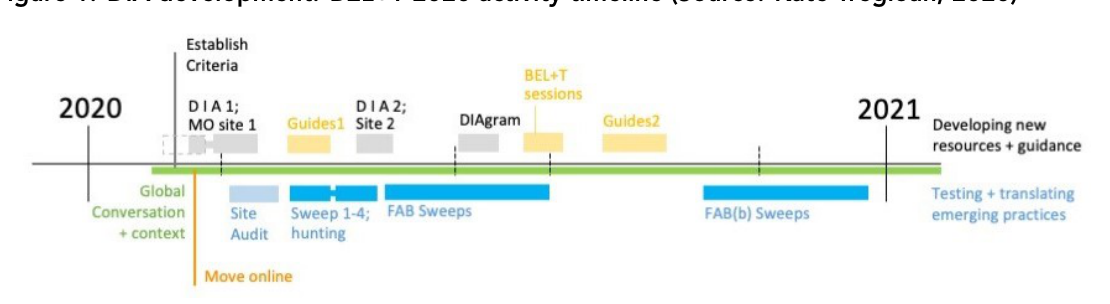
Figure 1. DIA development: BEL+T 2020 activity timeline (Source: Kate Tregloan,